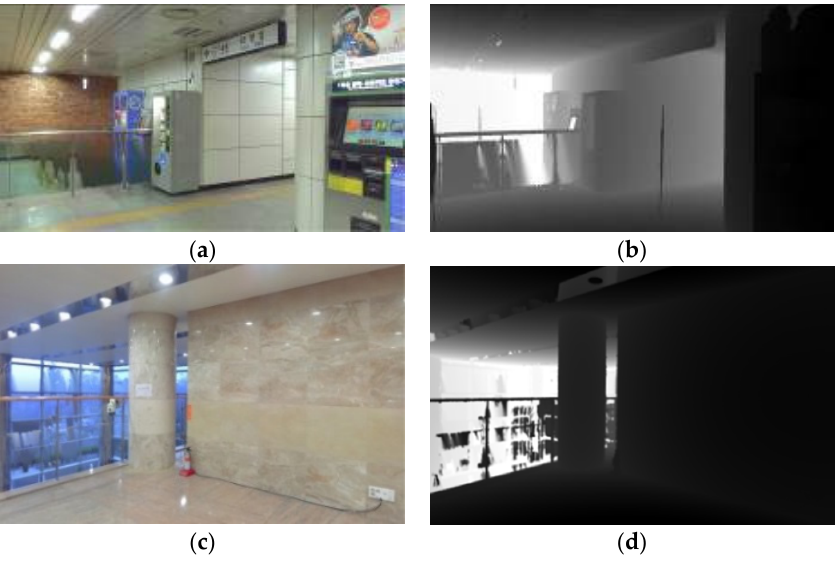
Figure 10. ( a ) An example of an RGB image in Bangbae; and ( b ) the corresponding range image. ( c ) An example in the ETRI building; and ( d ) the corresponding range image.